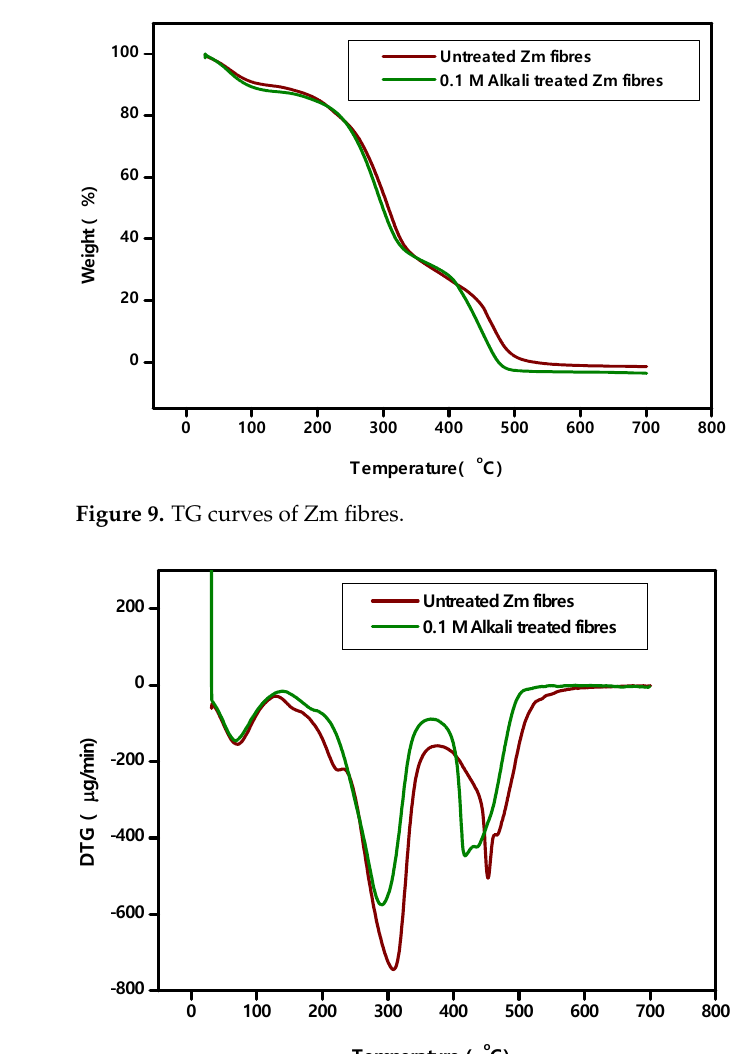
Figure 10. DTG curves of Zm fibres.